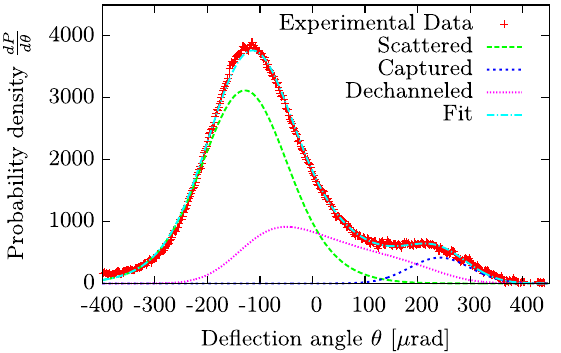
FIG. 16. The width of the channeling peak in the direction orthogonal to the plane is fitted with a power function (Fit 1), see Eq. (17) and to a function of the type a=